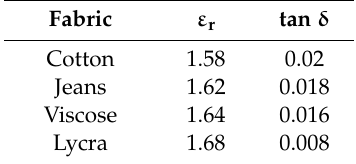
Table 1. Dielectric properties of